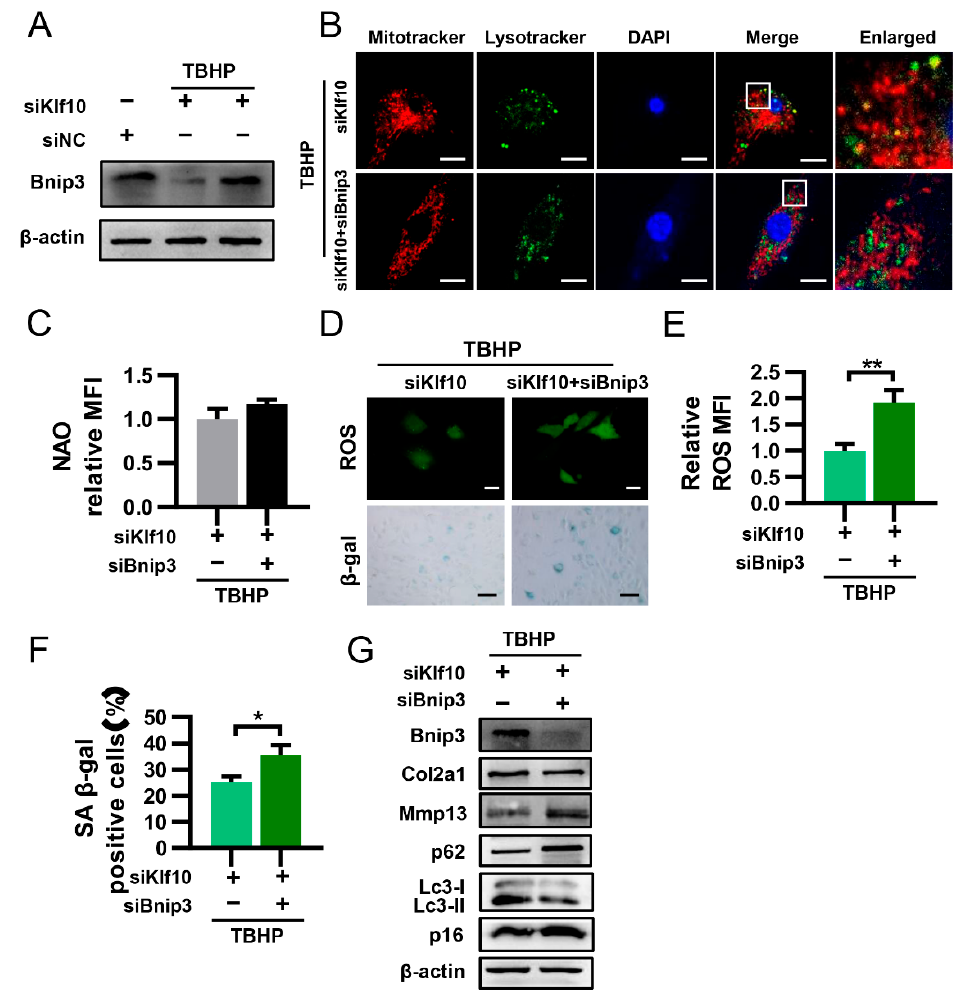
Figure 5. Downregulation of Klf10 promoted mitophagy by upregulating Bnip3. ( A ) After treating murine chondrocytes with TBHP with or without transfection with siKlf10, the protein expression of Bnip3 in each group was detected by Western blotting ( n = 3). ( B ) The chondrocytes were treated with TBHP and transfected with siKlf10 or both siKlf10 and siBnip3, followed by staining with MitoTracker Red (100 nM, 30 min) and LysoTracker Green (75 nM, 30 min) to label mitochondria and lysosomes. The co-localization of mitochondria and lysosomes was detected by confocal laser scanning microscopy. Scale bar: 20 µ m. ( C ) The chondrocytes were stained with NAO and detected by flow cytometry. The mitochondrial mass was quantized by the MFI ( n = 3). ( D – F ) Representative images of intracellular ROS and senescent chondrocytes of both groups. The intracellular ROS was quantized by the MFI of DCF and senescent chondrocytes were quantized by SA- β -Gal positive cells ( n = 3). Scale bar: 20 µ m. ( G ) Protein expression of Col2a1, Mmp13, p16, p21, Lc3, p62, and Bnip3 in both groups was determined by Western blotting. Data are presented as the mean ± SD. Student’s t test was used for comparisons between two groups. * p < 0.05, ** p <